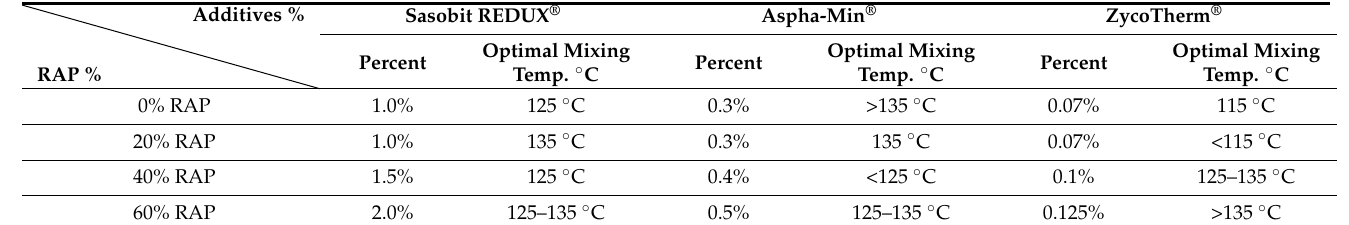
Table 19. The best percentages of the used WMA additives, in addition to the optimal mixing temperatures for each